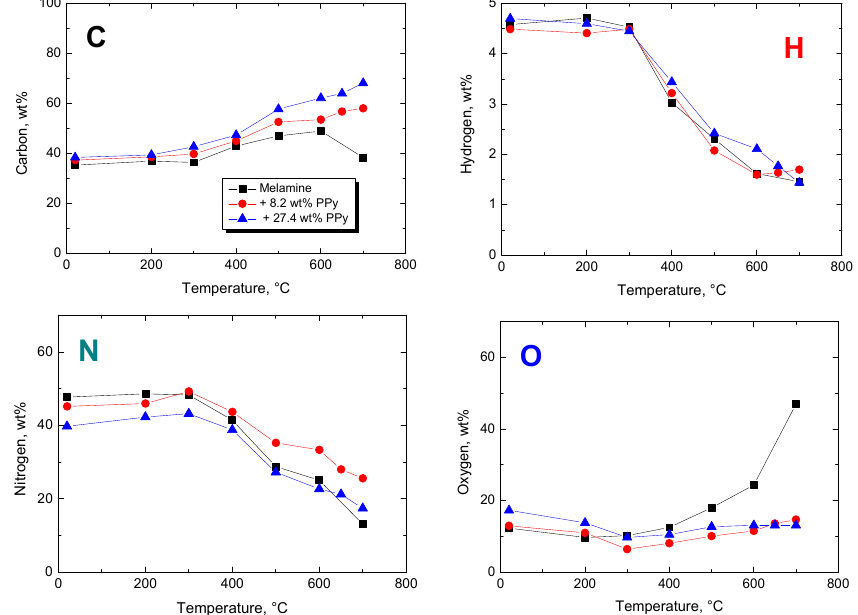
Figure 5. The composition of sponges exposed to various temperatures obtained by elemental CHN analysis; oxygen (including some chlorine) content was calculated as a residue.